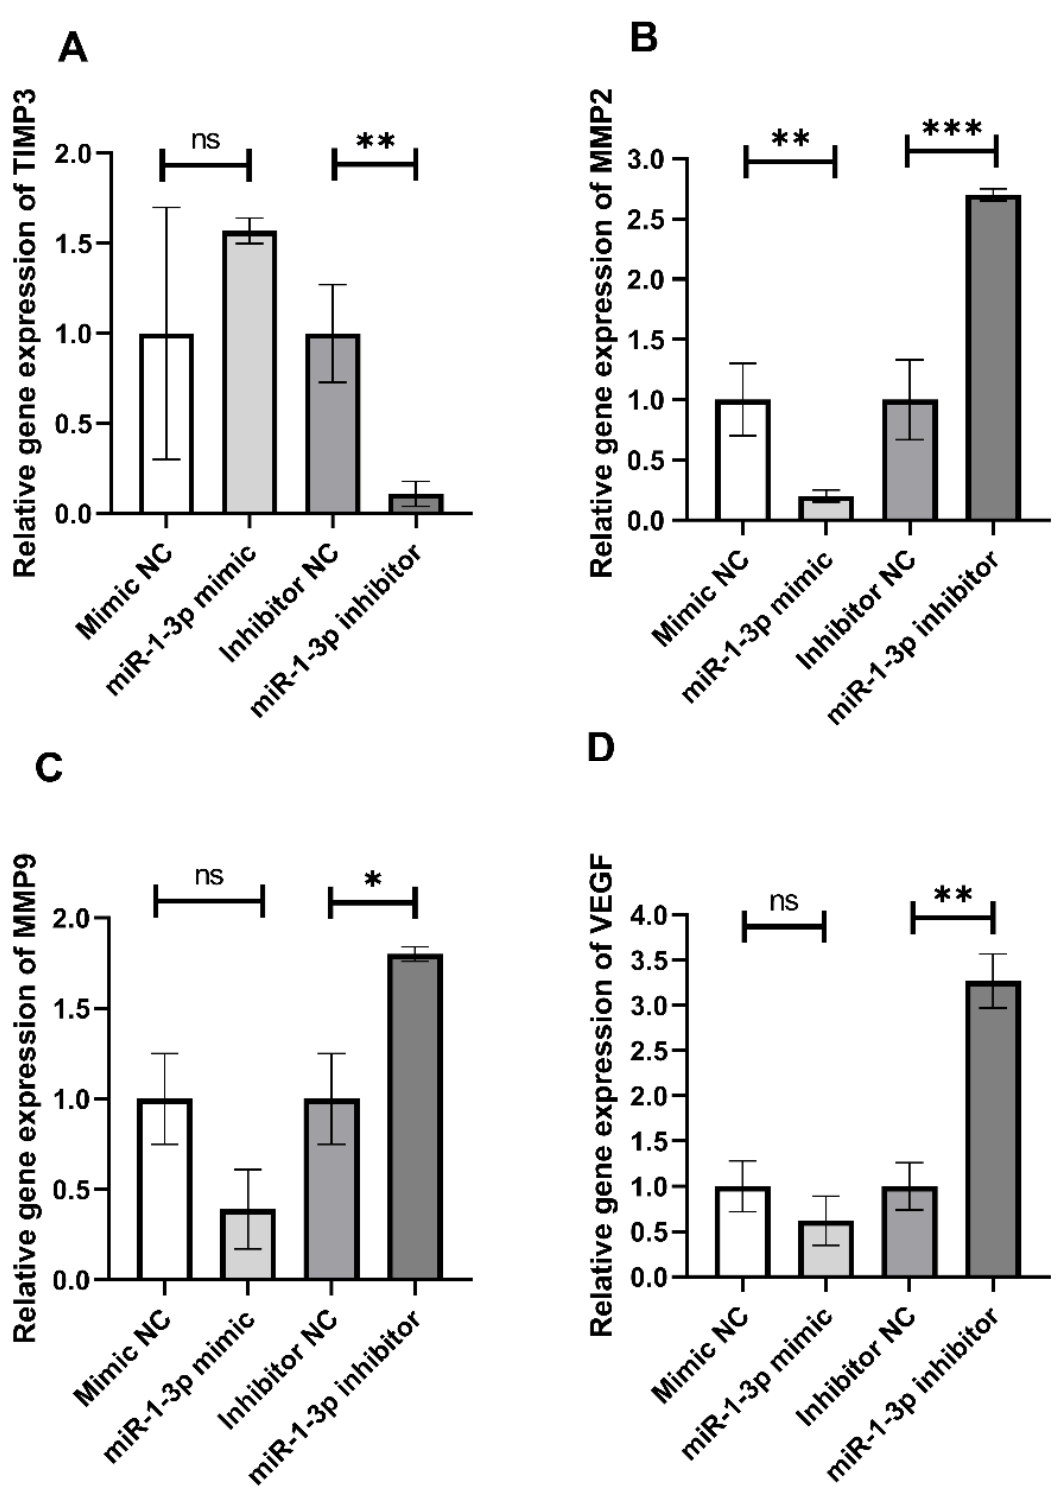
Figure 3. Relative TIMP3 ( A ), MMP2 ( B ), MMP9 ( C ), and VEGF ( D ) mRNA expression in HepG2 cells transfected with miR-1-3p mimic, inhibitor, and their NC. Transfection of HepG2 cells was done with 50 nM of human miR-1-3p mimic, inhibitor, or their corresponding negative controls using HiPerFect transfection reagent for 48 h. Each column represents mean ± SD of three separate experiments. Unpaired t -test was used to compare between the two groups. * Significant at p < 0.05, ** significant at p < 0.001, and *** significant at p <